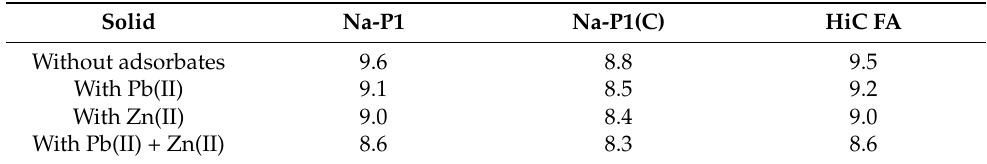
Table 5. Comparison of the pH pzc values of HiC FA, Na-P1, Na-P1(C) particles in the absence or presence of heavy metal ion/ions.